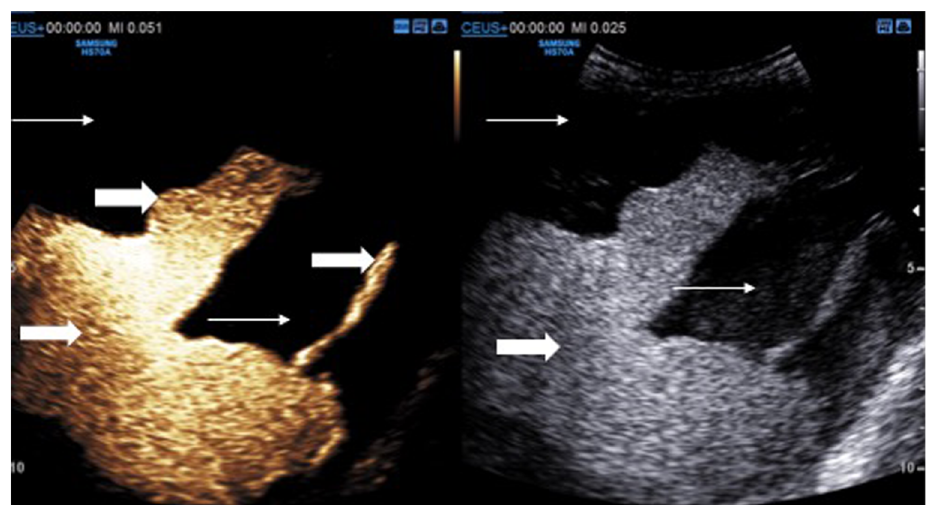
Fig. 3 CEUS image following ultrasound contrast administration through the in-dwelling pleural catheter with simultaneous greyscale image. Contrast is confined to a solitary pleural loculation (thick arrows), confirming the drain lies within an isolated locule. The remaining pleural fluid is not opacified and does not communicate with the in-dwelling drain (thin arrows)